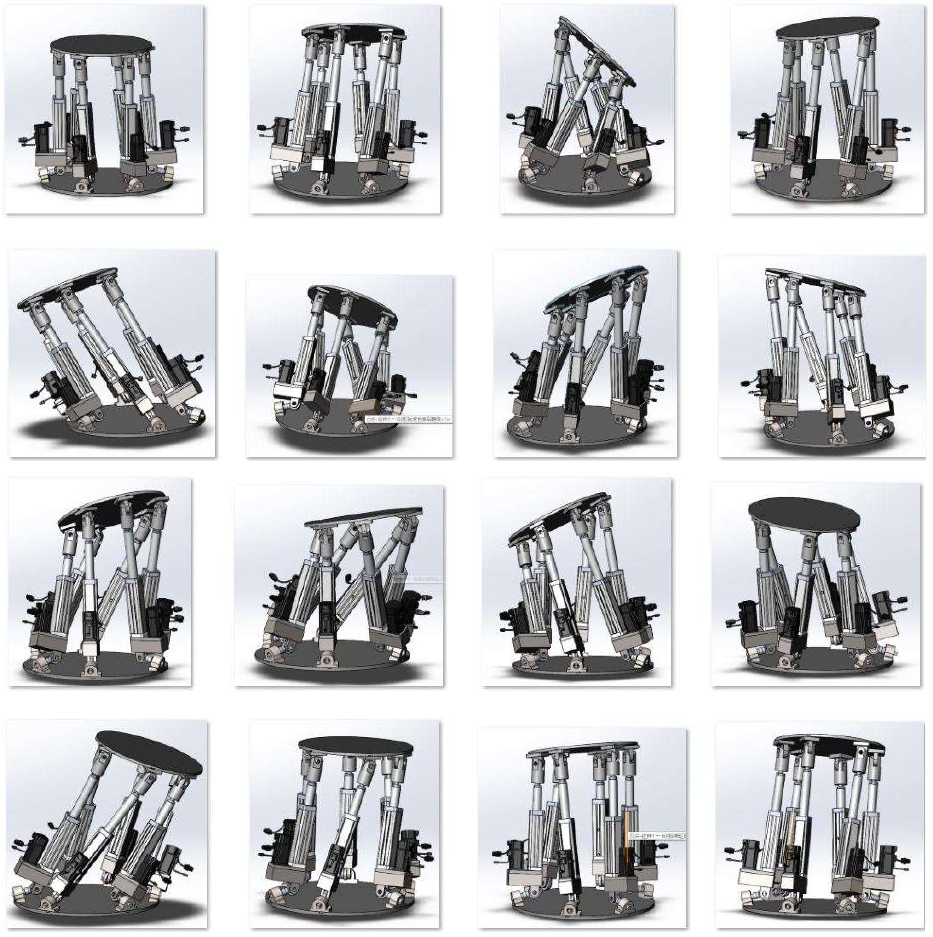
Figure 7. Interference verification of 16 extreme positions and postures of lifting platform.